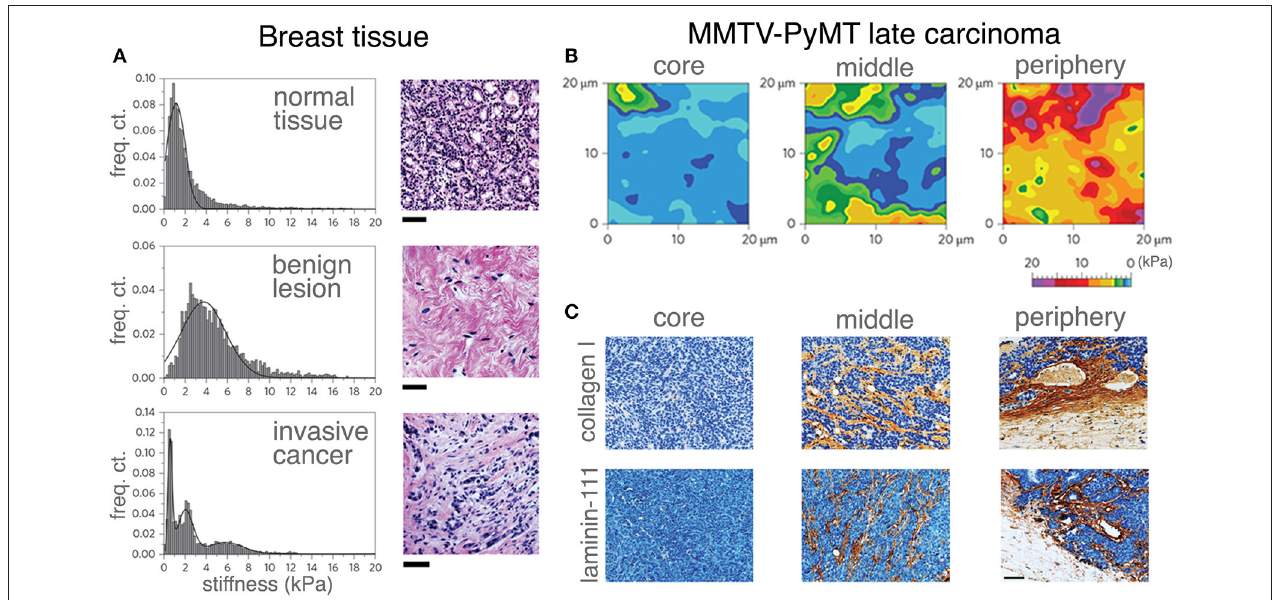
FIGURE 3 | Correlating mechanical properties and ECM reorganization during human breast cancer progression. Stiffness distribution and respective H&E stained sections (A) of normal mammary gland tissue (top), benign lesion (middle) and malignant tumor (bottom). Stiffness distribution of normal breast tissue is unimodal and the histology shows the terminal ductal lobular unit of a normal mammary gland fenced by interstitial connective tissue. A benign lesion reveals a unimodal, but broader stiffness distribution with an increase in stiffness compared with the healthy sample. The histology of benign lesions reveals extensive fibrotic stroma interspersed with fibroblasts typical for fibroadenoma. Invasive cancer shows heterogeneous stiffness distribution with a characteristic soft peak, where the histology shows an invasive breast carcinoma with infiltrating nests of cancer cells that have evoked a dense fibrous tissue response. Scale bar applies to all images, 50 µ m. The distinct ECM stiffness and structure of late MMTV-PyMT cancer was probed by atomic force microscopy (B) and immunohistochemistry (C) . Gradual stiffening from the core to the periphery was observed. Mechanical heterogeneity increased and is most extensive at the periphery (B) . While collagen type I and laminin-111 were virtually absent in soft tissue (the core), the heterogeneous presentation (brown staining) of collagen type I and laminin-111 was increased at the periphery as evidenced in (C) . Scale bar applies to all images, 50 µ m. ( A–C reproduced with permision from Plodinec et al., 2012).